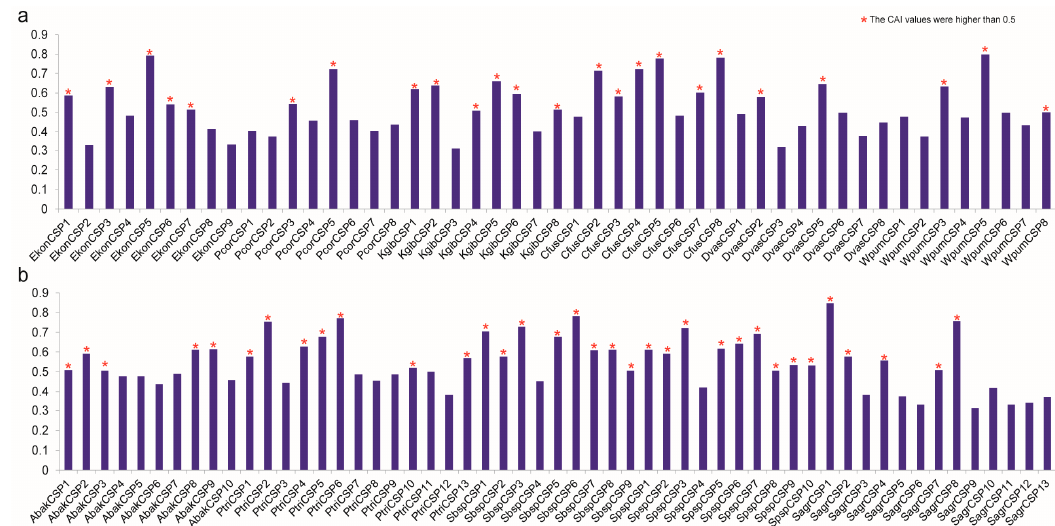
Figure 6. The codon adaptation index (CAI) values of 104 CSP genes in the 11 fig wasps. The red asterisks represent the CSP genes whose CAI values are higher than 0.5. ( a ) The CAI values of CSP genes in six pollinating fig wasps. ( b ) The CAI values of CSP genes in five non-pollinating fig wasps.